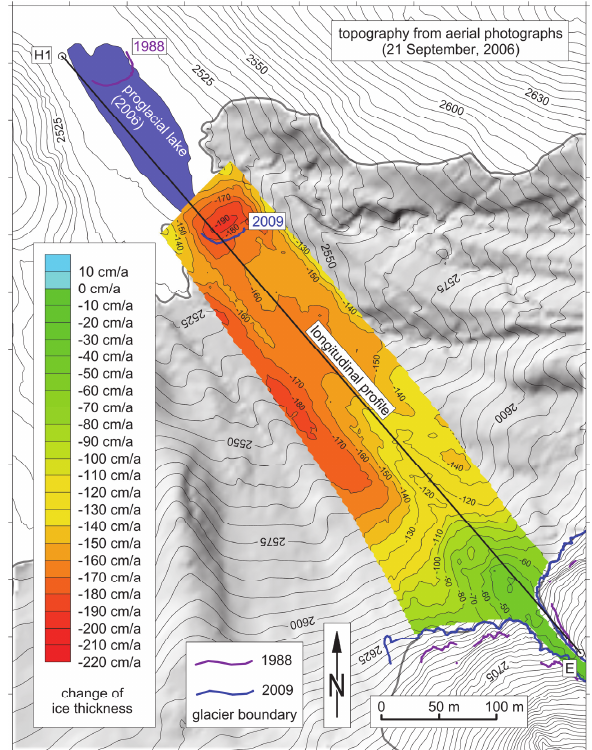
Figure 6. Terrestrial photogrammetric documentation of change in ice thickness of Gössnitzkees for the period 1988-2009.